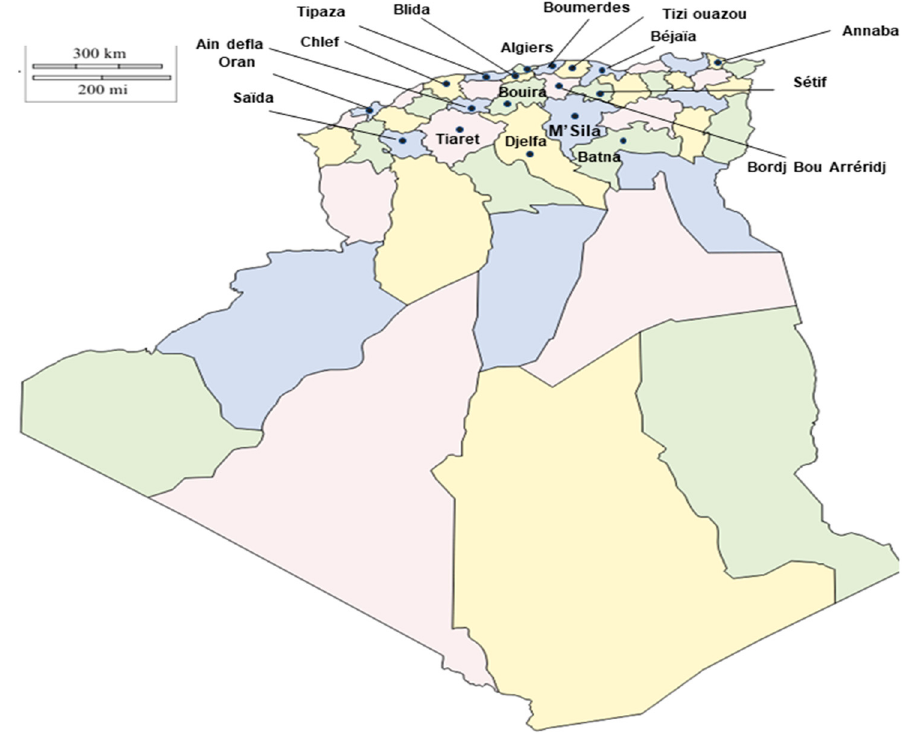
Figure 1. Map of Algeria displaying the 18 provinces sampled for S. aureus and Methicillin-resistant Staphylococcus aureus (MRSA) prevalence in poultry farms.